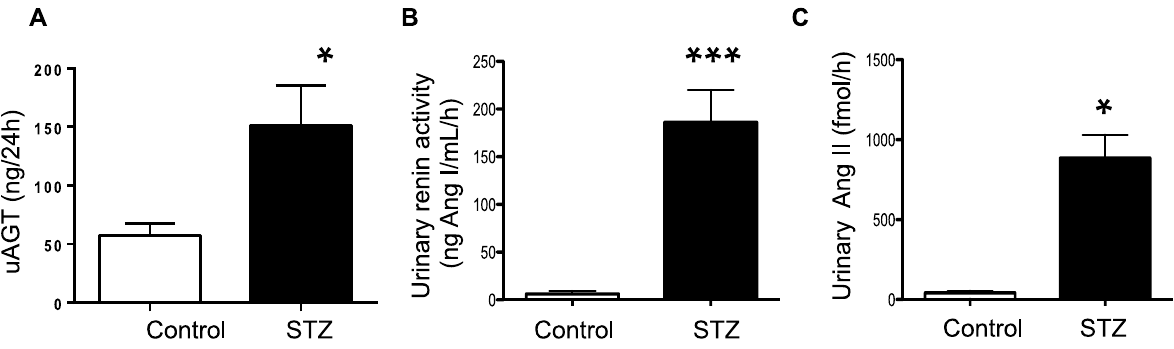
Figure 3. Urinary excretion of RAS components in the urine. Urinary angiotensinogen (AGT) ( A ), Urinary renin activity ( B ) and urinary Ang II levels ( C ) in control (n = 7) and STZ-induced diabetic rats (n = 9) *P < 0.05 versus control